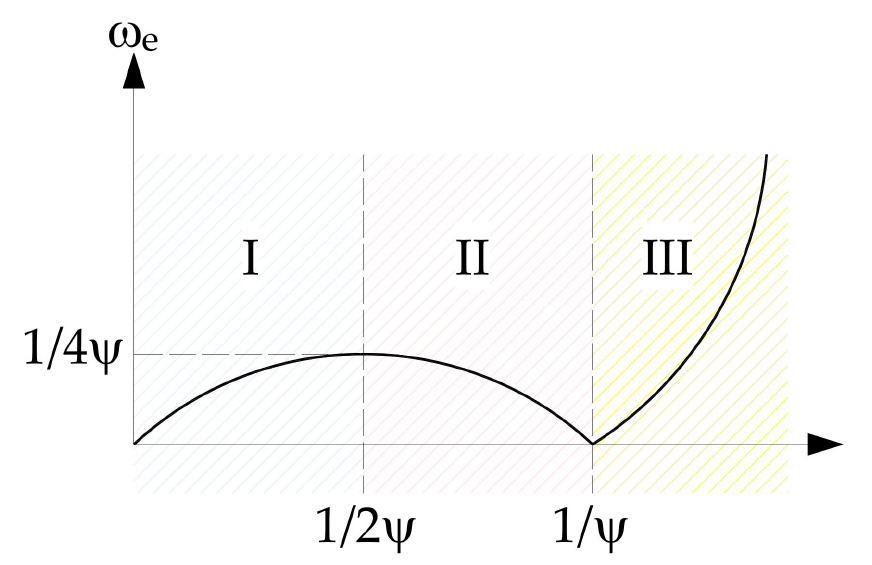
Figure 12. The 1-to-3 multivalued problem between the encounter and the absolute wave